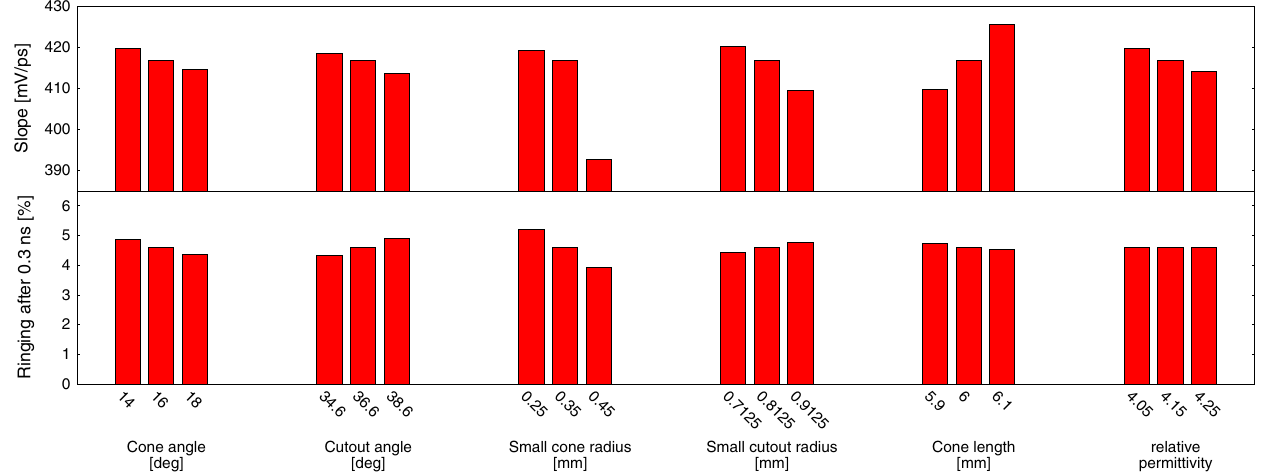
FIG. 4. Influence of geometric variations on the slope (top) and on the ringing